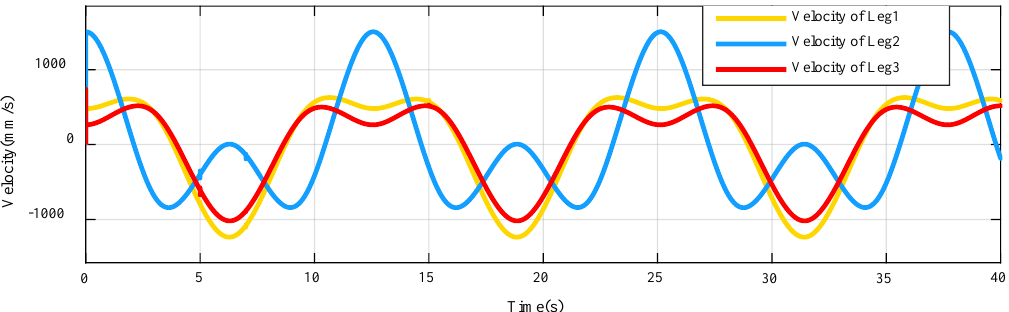
Figure 28. Velocity of branch legs of the original compensation platform during the compensation to the simulative wave.